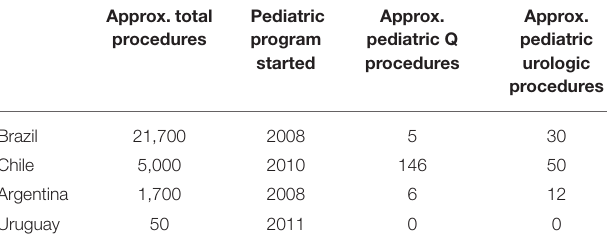
TABLE 4 | Robot utilization by country.